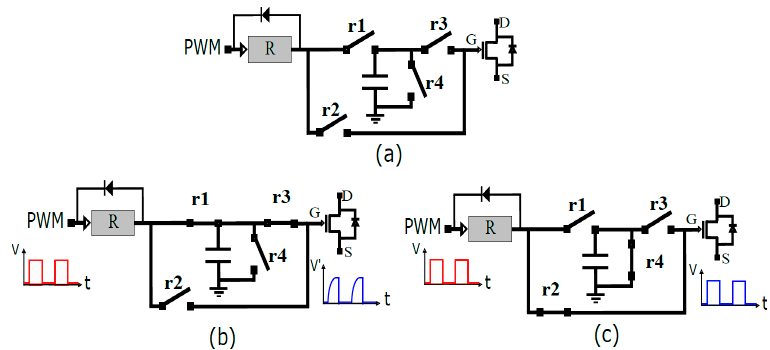
Figure 8. Global schematic of the proposed control method: ( a ) r1, r2, r3, and r4 relays are on; ( b ) r1 and r3 relays are on to activate the R-C filter effect; ( c ) r2 and r4 relays are on to deactivate the R-C filter effect.